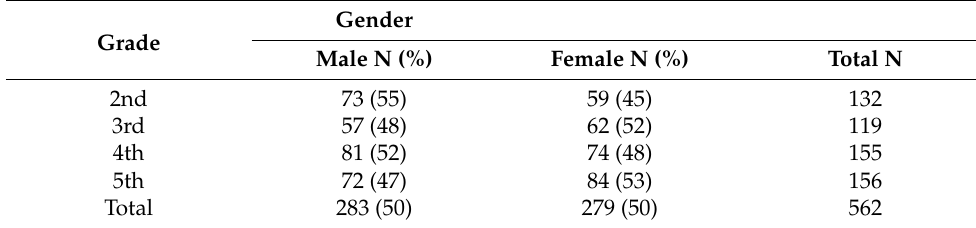
Table 1. Number of children of the sample divided for grade level and gender. Grade